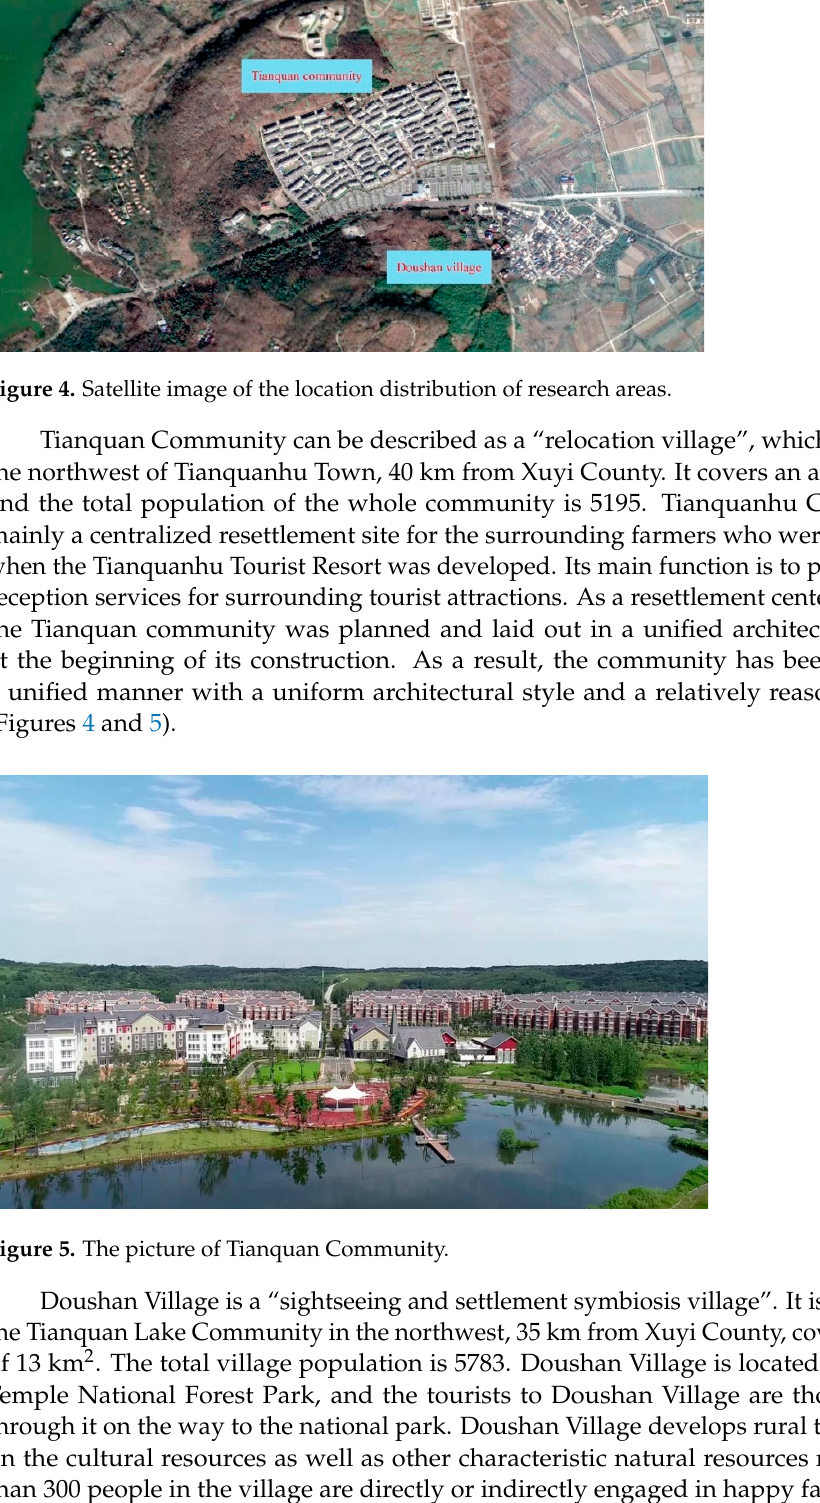
Figure 3. The geographical locations of research areas.